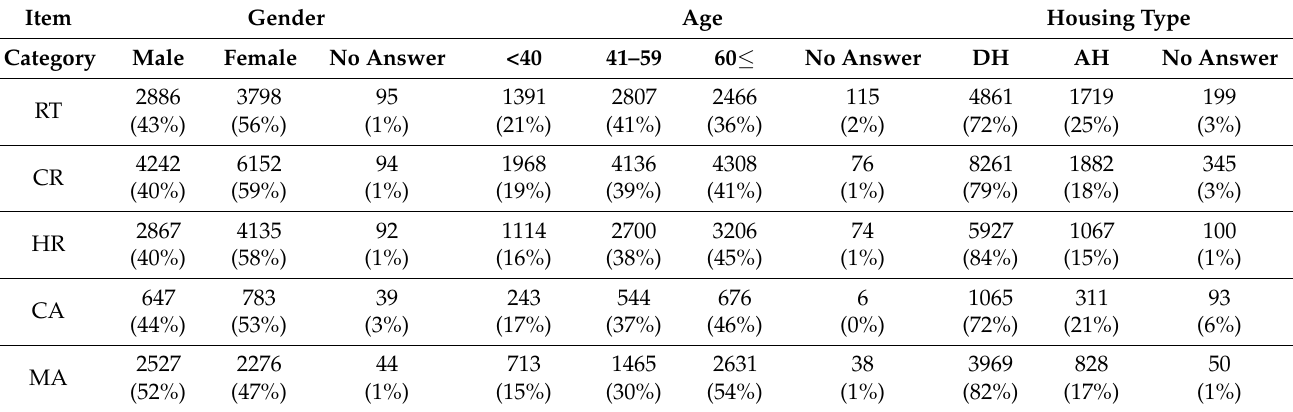
Table 3. Frequency of distributions of demographic factors and housing type for each noise. DH and AH in housing type indicate detached house and apartment house, respectively.